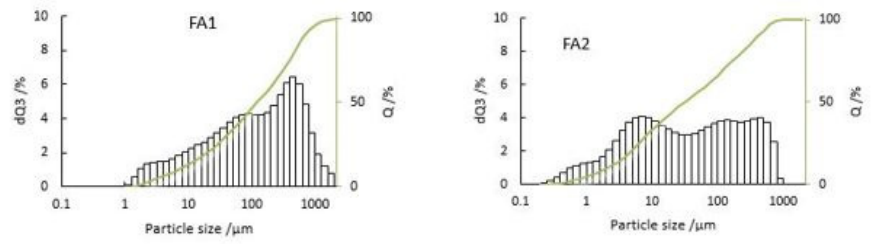
Figure 2. Particle size distribution of fly ash FA1 and FA2.